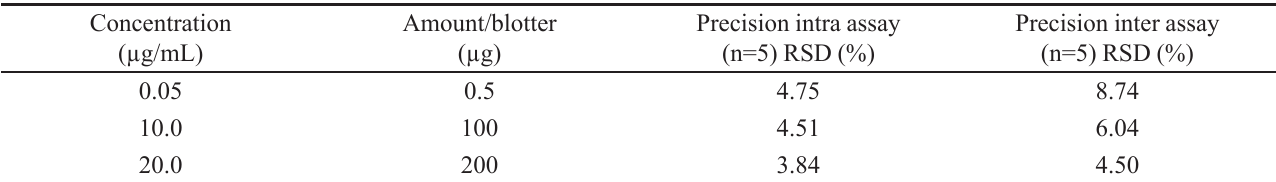
TABLE II - Mean and intra and inter assay relative standard deviation precision at different levels of LSD Concentration